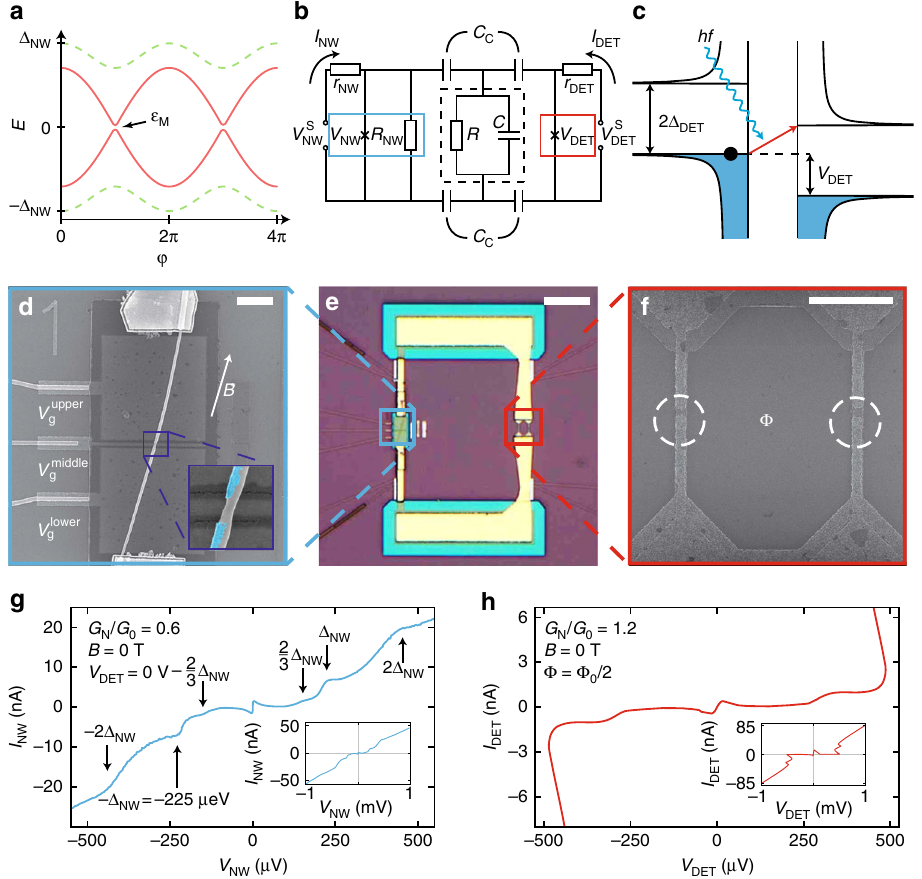
Fig. 1 Principles of the experiment. a Energy dispersion of topologically trivial (dashed green line) and nontrivial (solid red line) Andreev levels inside a NW Josephson junction as a function of the phase difference across the junction. The gap ε M arises from the fi nite MZM wavefunction overlap. b Equivalent circuit diagram of the device. The NW junction (in blue box) is capacitively coupled to the superconducting tunnel junction (red box) via the capacitors C C . The microwave losses and stray capacitance are modeled by the RC element enclosed by the dashed black box, see text. The applied DC bias voltages are V S and V S with an effective internal resistance r NW and r DET , respectively. c Principle of the frequency-sensitive detection based on photon-assisted NW DET tunneling: an absorbed photon with an energy hf gives rise to quasiparticle current if hf > 2 Δ DET - eV DET . d Scanning electron micrograph of the NW junction placed on three electrostatic gates. A false color micrograph of the junction is shown in the inset, with the epitaxial Al shell highlighted in cyan. e Bright- fi eld optical image of the coupling circuitry between the NW junction (blue box) and the detector junction (red box). f Micrograph of the split tunnel junction detector. The junctions are encircled. g Measured I NW ( V NW ) characteristics of the NW junction at zero in-plane magnetic fi eld exhibiting a supercurrent branch and multiple Andreev re fl ections. h Measured I DET ( V DET ) trace of the detector split junction at zero in-plane magnetic fi eld with a minimized switching current. The insets in ( g ) and ( h ) show the large scale I ( V ) trace of each junction. The normal state conductance G N is given in the units of G 0 = 2 e 2 / h . All images and data were taken on device NW1. The scale bars denote 1 μ m ( d ), 10 μ m ( e ), and 1 μ m ( f ),